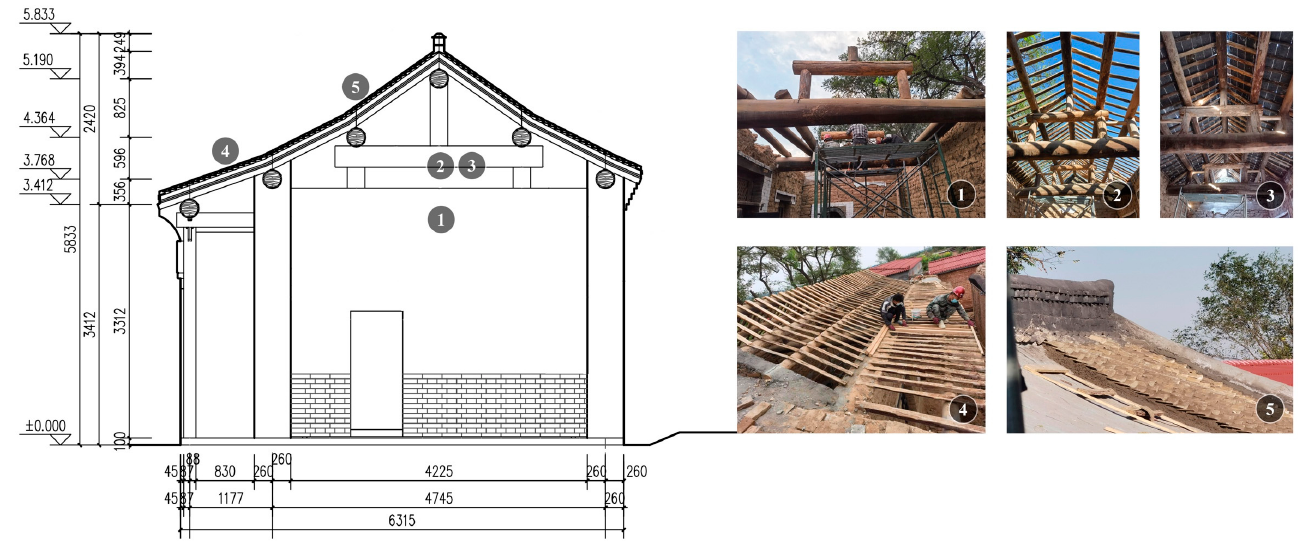
Figure 11. Building side rehabilitation practices.